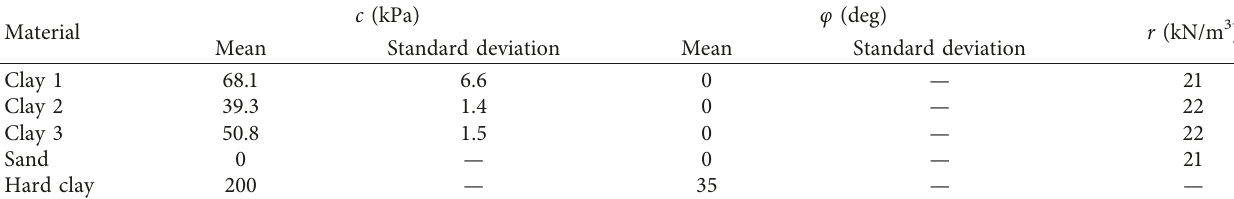
Figure 9: Geometry of slope of Example 4. Table 12: Material properties of the soil of Example 4.